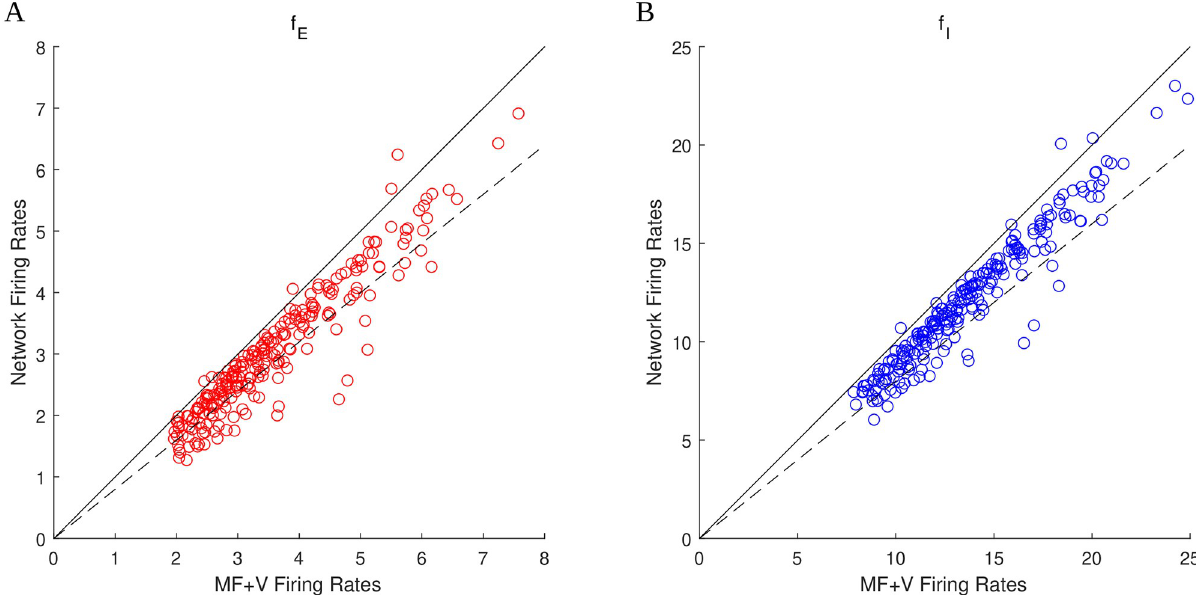
Fig 5. Comparison of firing rates computed using the MF+v algorithm to those from direct network simulations. The scatter plots show results for 128 sets of parameters randomly chosen in or near the good areas in Figs 1–4. A. Comparison of f y = 0.8 x . A majority of data points fall in the range of 20%